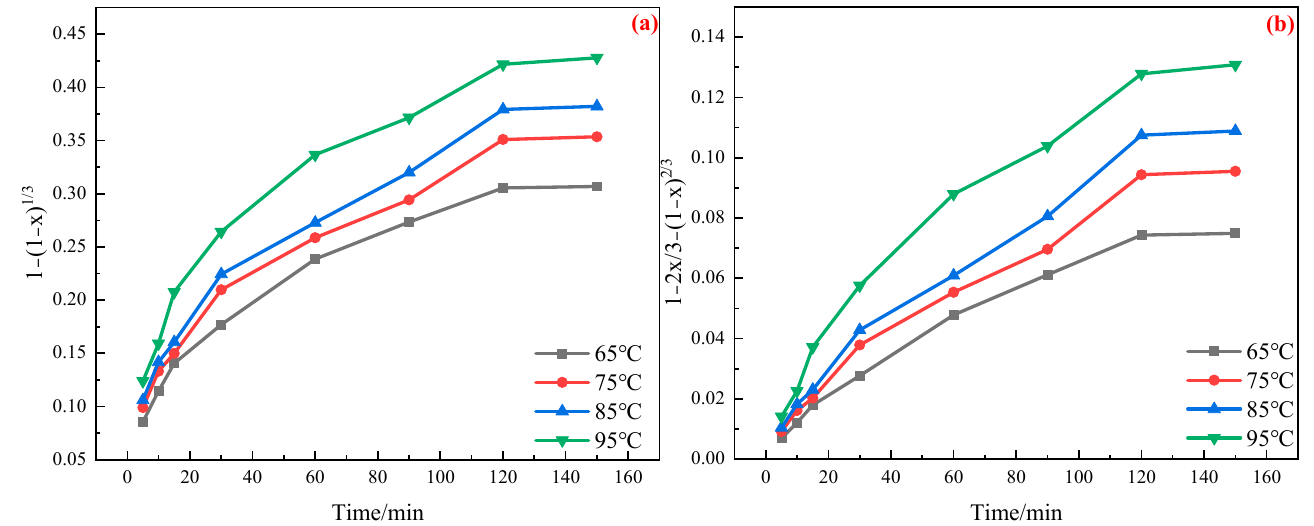
Figure 8. G(a)-t lines of the Al 2 O 3 leaching rate of the MPRS under 65–95 °C (( a ): 1 − (1 − x) 1/3 − t, ( b ): 1 − 2x/3 − (1 − x) 2/3 − t). Table 5. The G(a)-t correlation coefficient obtained from the linear fit of the Al 2 O 3 leaching rate of the MPRS.